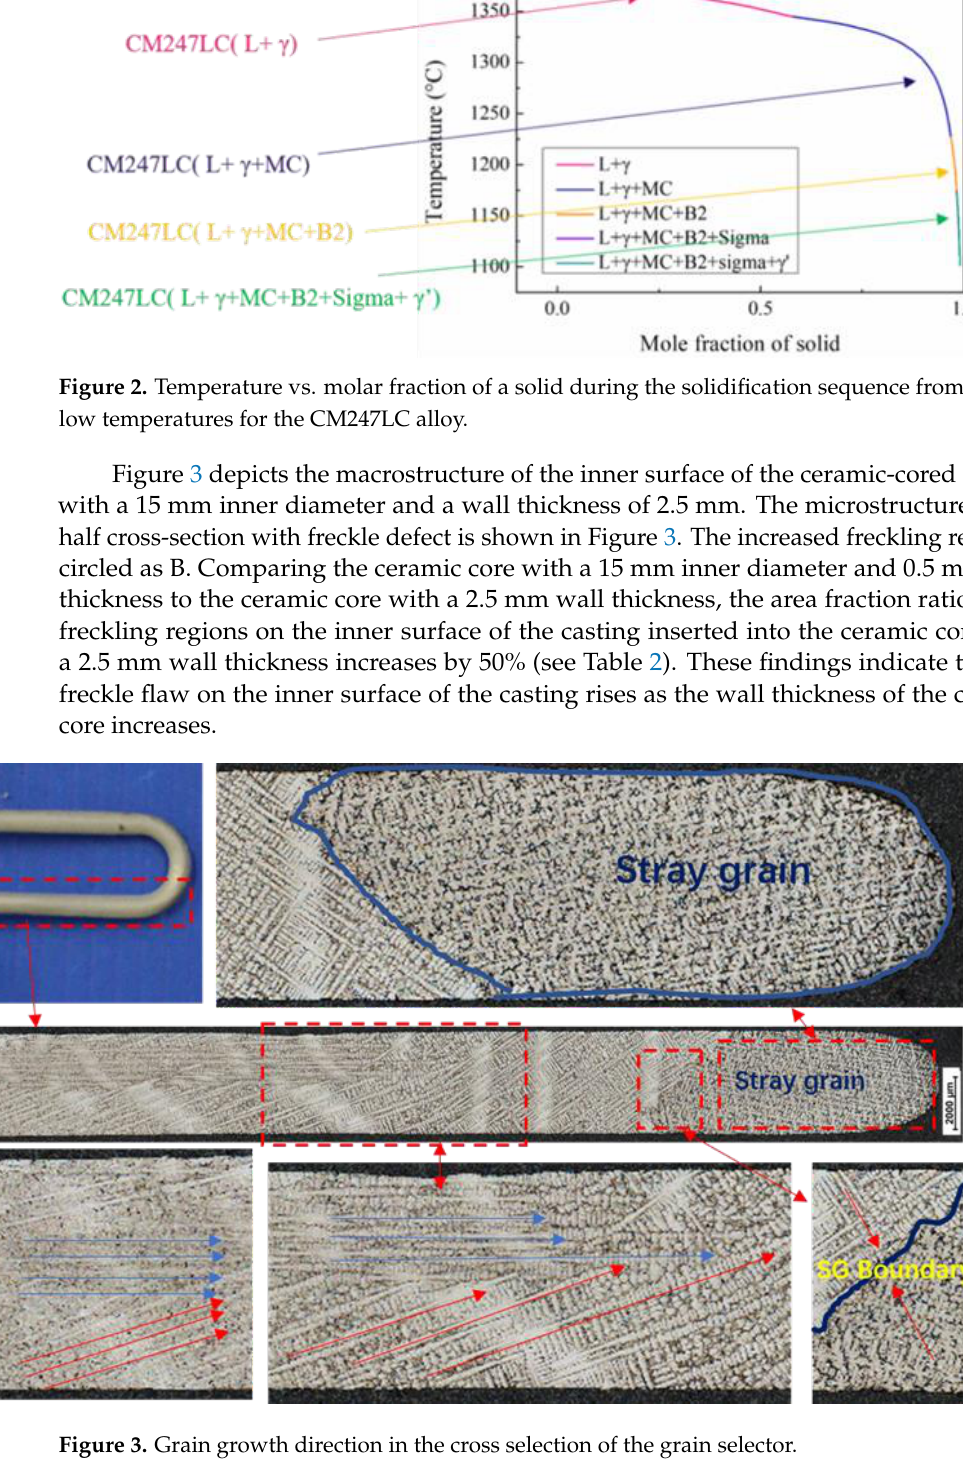
Figure 1. Equilibrium phase fractions between the solidus and liquidus temperatures in experi- mental alloys: calculated mole fraction of the equilibrium phases for the alloys [15].